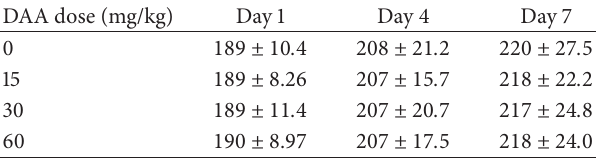
Table 1: Mean ( ± standard deviation) weight (g) per